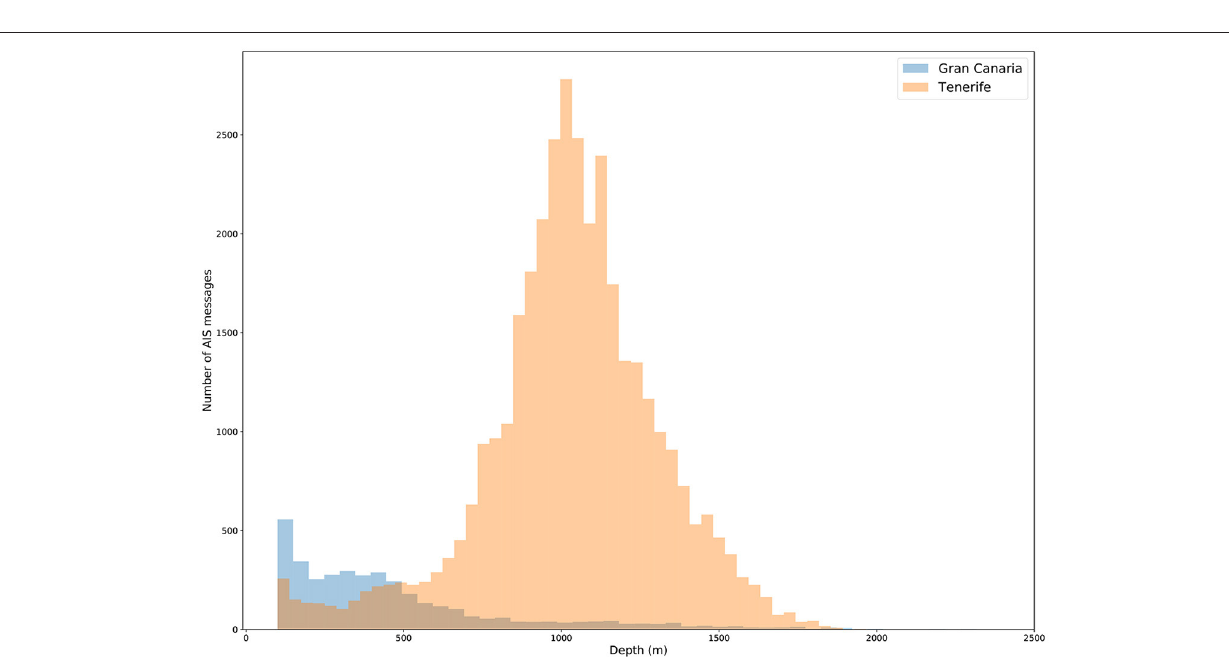
created to detect sequences in the AIS messages that could fit this simple model of pilot whale observation. A data sequence was defined to start when the speed of the boat was under